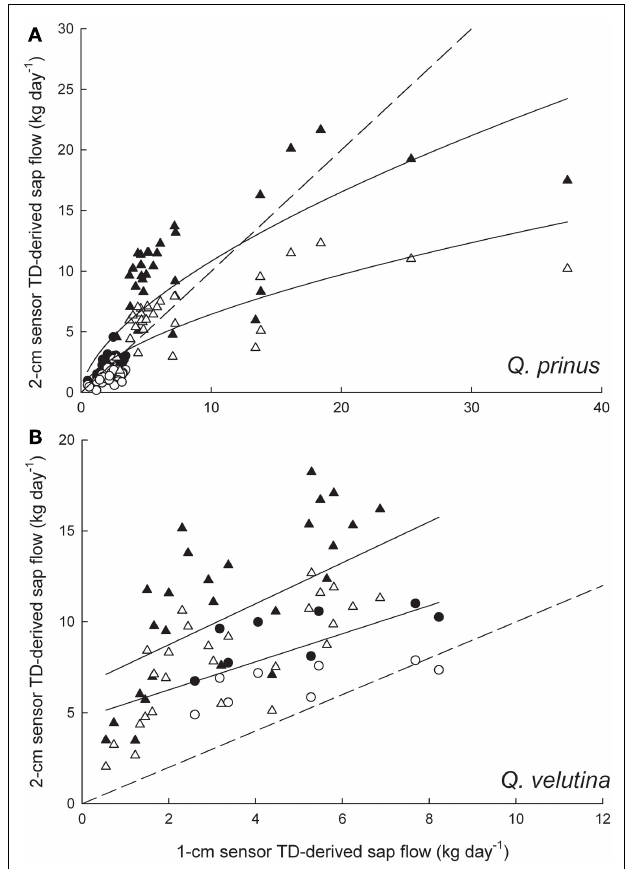
FIGURE 4 | Comparison of sap flow rates measured with 1 and 2-cm long thermal dissipation (TD) sensors in (A) two Q. prinus individuals (circles – 16.8cm dbh, triangles 17.7cm dbh individual) and (B) a 19.5-cm dbh Q. velutina individual (circles – 2010 data, triangles – 2011 data). Open symbols denote sap flow rates derived from the original Granier equation and closed symbols are sap flow rates with the Clearwater correction applied to the 2-cm long sensor data.The dashed lines are the one to one lines and the solid lines are the best fits for (A) uncorrected data ( y = 1.65 × x 0.59 , r 2 = 0.63) and Clearwater-corrected data ( y = 2.65 × x 0.61 , r 2 = 0.65) and (B) uncorrected data ( y = 0.77 x + 4.7, r 2 = 0.34) and Clearwater-corrected data ( y = 1.13 x + 6.5, r 2 = 0.34).